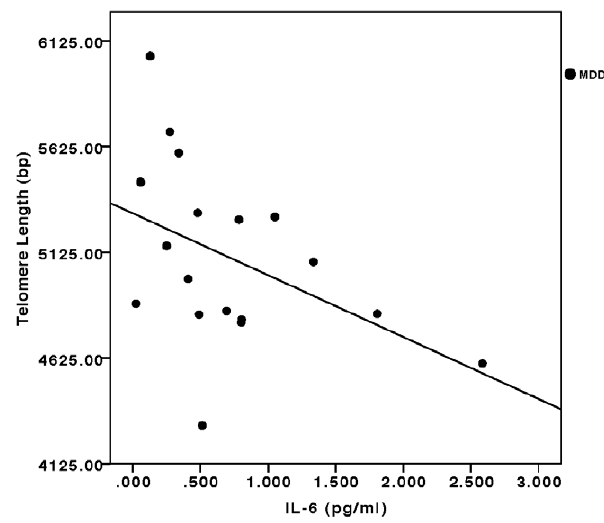
Figure 3. Relationship between serum IL-6 concentrations (pg/ ml) and leukocyte telomere length (in base pairs, bp) in depressed subjects. (F= 3.29, p , 0.05, controlling for age, sex and BMI). The relationship missed significance in the combined sample (depressed plus controls) (F= 2.45, p=0.07, controlling for age, sex and BMI) and was not significant in the controls alone (not plotted) (F= 2.28, p= 0.13, controlling for age, sex and BMI).